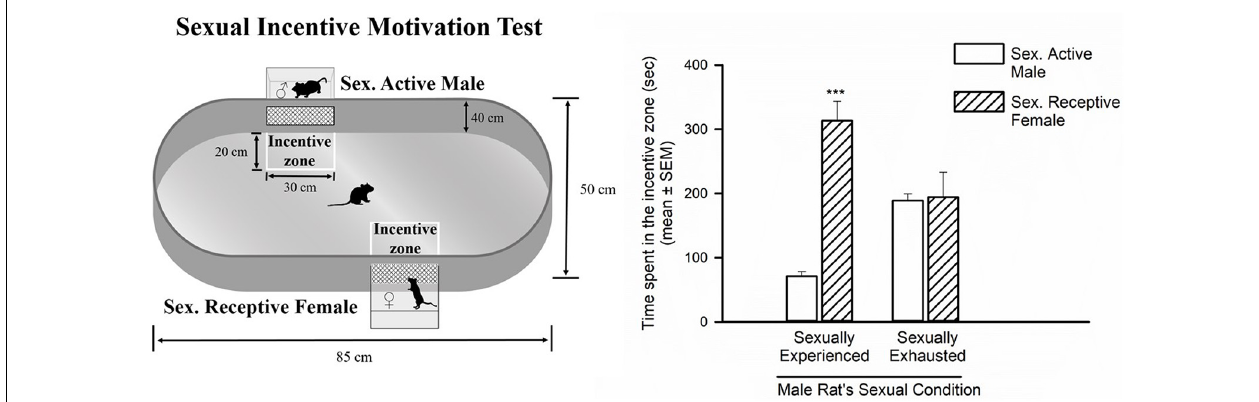
FIGURE 2 | Sexual incentive motivation is measured as the time spent by the male rat in the incentive zones of the sexually receptive female (dashed bars) or the male (empty bars), in control sexually experienced ( n = 12) and in sexually satiated male rats ( n = 12). Data in the graph are expressed in seconds (s) as mean ± SEM. A statistically significant difference was found in the sexually experienced males in the time spent in each of the incentive zones. Mann-Whitney U test, ∗∗∗ P < 0.001. The features of the apparatus used to evaluate sexual incentive motivation are depicted on the left side of the